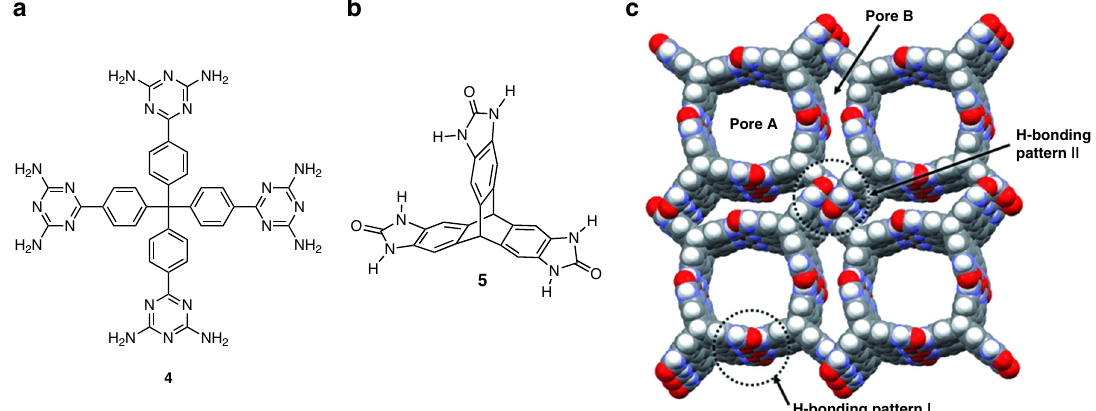
Fig. 8 Structures of selected HOFs. a Molecular structure of tetrakis(diaminotriazine) 4 . b Molecular structure of triptycenetrisimidazolone 5 . c Structure of a HOF derived from compound 5 . Adapted with permission from Wiley, ref. 61